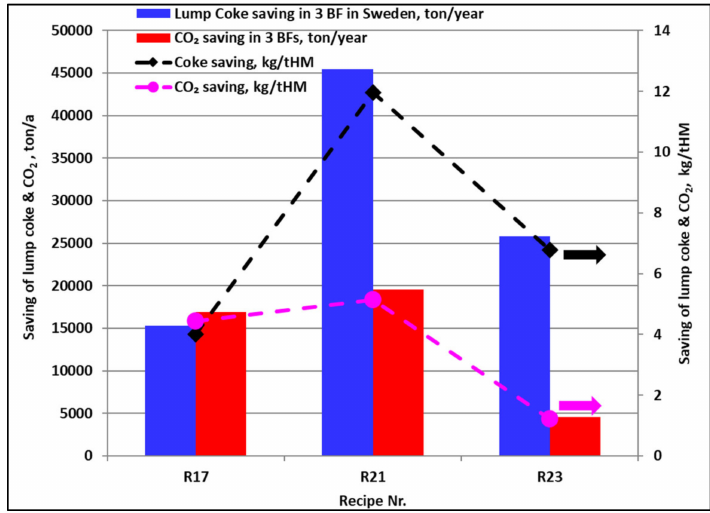
Figure 12. Coke and CO 2 saving by charging developed